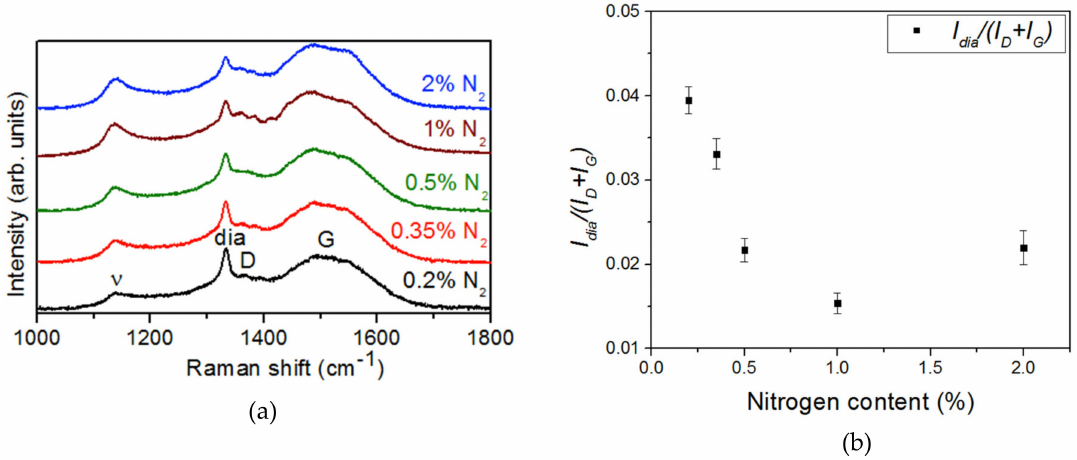
Figure 3. ( a ) Raman spectra of the NCD samples grown with di ff erent N 2 concentrations. ( b ) Dia and G + D bands ratio ( I dia / (I d + I g ) ) for each nitrogen